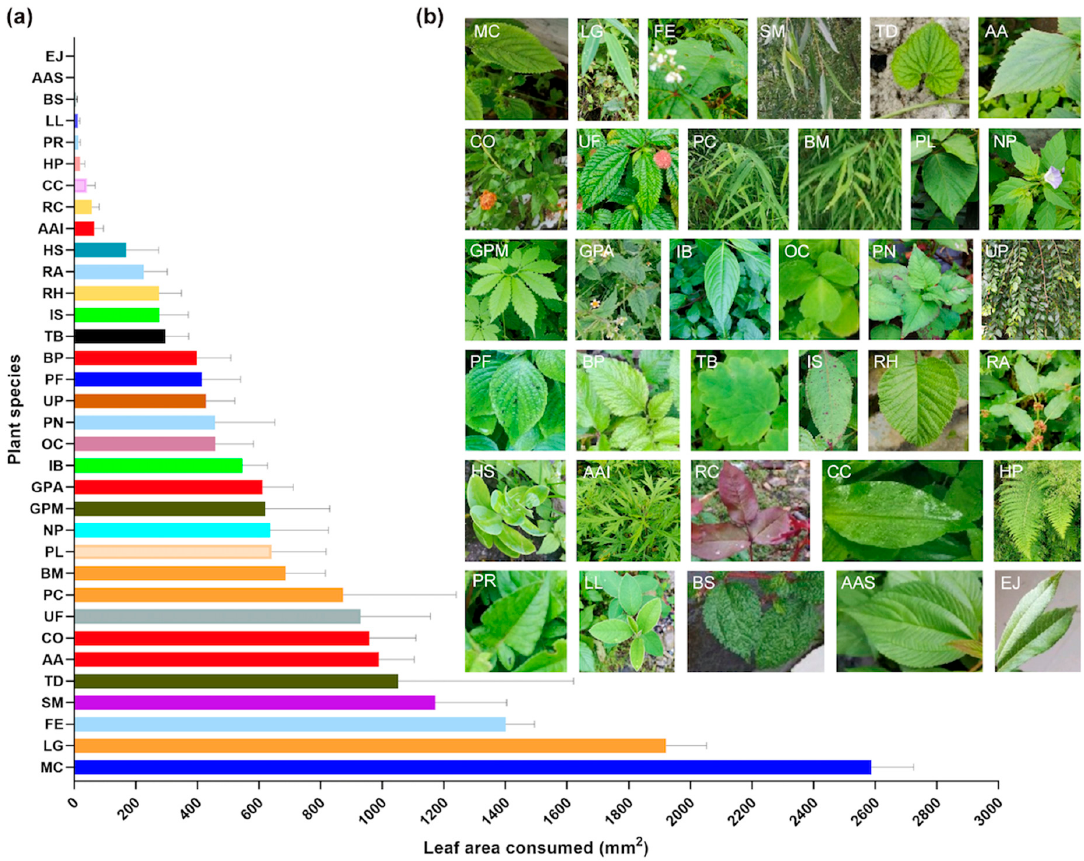
Figure 5. Desert locusts’ food preferences for some Tibetan plants. ( a ) Leaf area consumed by locusts ( n = 10, female:male = 1:1; same color bars represent plants of the same family). ( b ) Leaf aspect of the 34 plant species tested: MC, Mentha canadensis (syn. M. haplocalyx ); LG, Lophatherum gracile ; FE, Fagopyrum esculentum ; SM, Salix matsudana ; TD, Thladiantha dubia ; AA, Ageratina adenophora (syn. Eupatorium adenophorum ); CO, Calendula officinalis ; UF, Urtica fissa ; PC, Pogonatherum crinitum ; BM, Bambusa multiplex ; PL, Pueraria lobata ; NP, Nicandra physalodes ; GPM, Gynostemma pentaphyllum ; GPA, Galinsoga parviflora ; IB, Impatiens balsamina ; OC, Oxalis corniculata ; PN, Polygonum nepalense ; UP Ulmus pumila ; PF, Perilla frutescens ; BP, Bidens pilosa ; TB, Thalictrum baicalense ; IS, Impatiens siculifer ; RH, Rubus hirsutus ; RA, Rumex acetosa ; HS, Hylotelephium spectabile (syn. Sedum spectabile ); AAI, Artemisia argyi ; RC, Rosa chinensis ; CC, Commelina communis ; HP, Hypolepis punctata ; PR, Polygonum runcinatum ; LL, Ligustrum lucidum ; BS, Boehmeria spicata ; AAS, Acalypha australis ; EJ, Eriobotrya japonica.